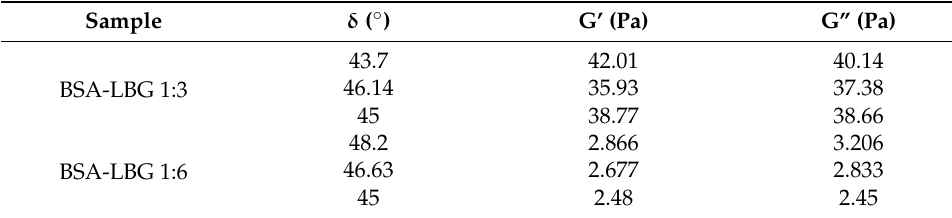
Table 2. Calculated viscosity values by linear interpolation process.